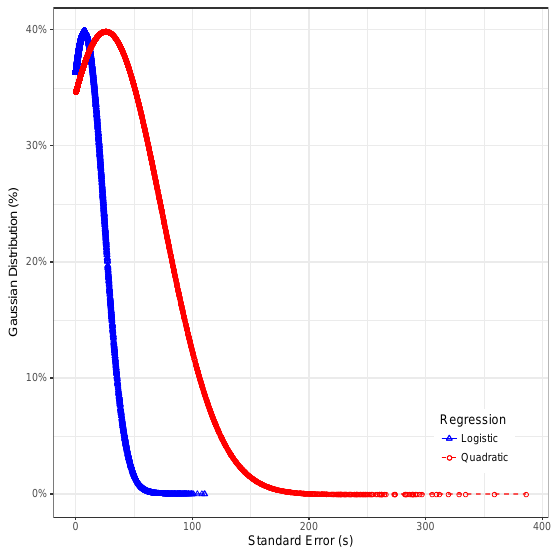
Figure 5. Standard error of